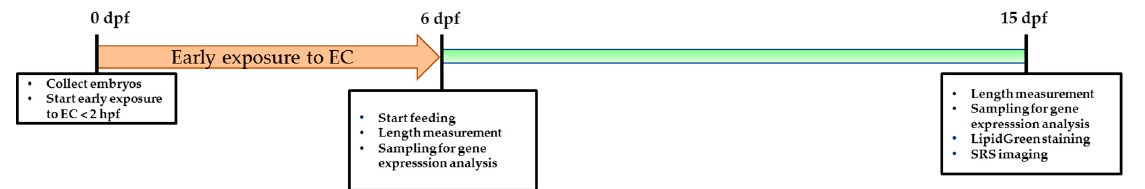
Figure 12. Schematic representation of the procedure used to analyze the effects of environmental chemicals (EC) on adipocyte development in zebrafish larvae